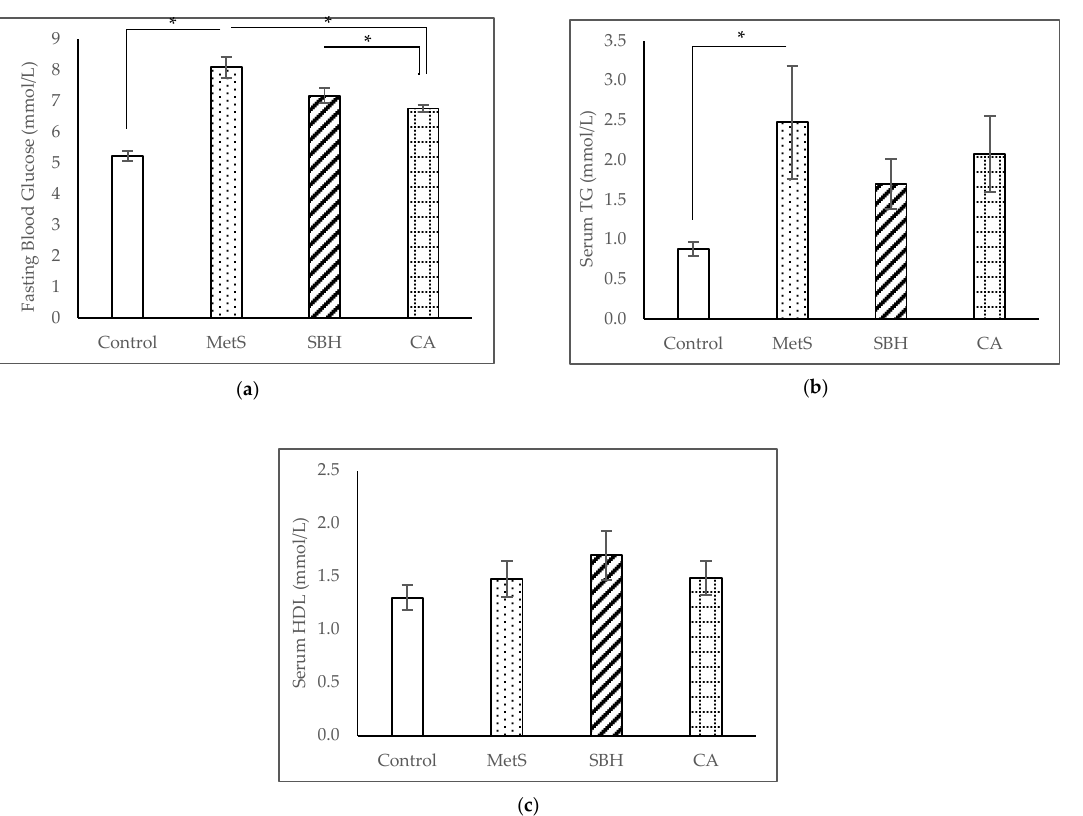
Figure 3. Effects of MetS induction and SBH and CA supplementation on biochemical parameters of the experimented rats: changes in ( a ) FBS; ( b ) serum TG; and ( c ) serum HDL. Data are presented as mean ± SEM ( n = 7). * p < 0.05.